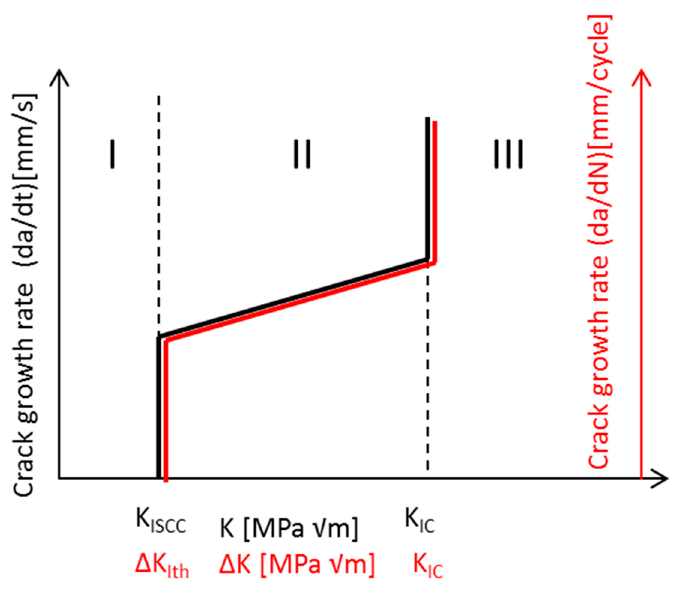
Figure 9. Paris curve (red line); Paris-like curve for Stress Corrosion Cracking (SCC) (black line).